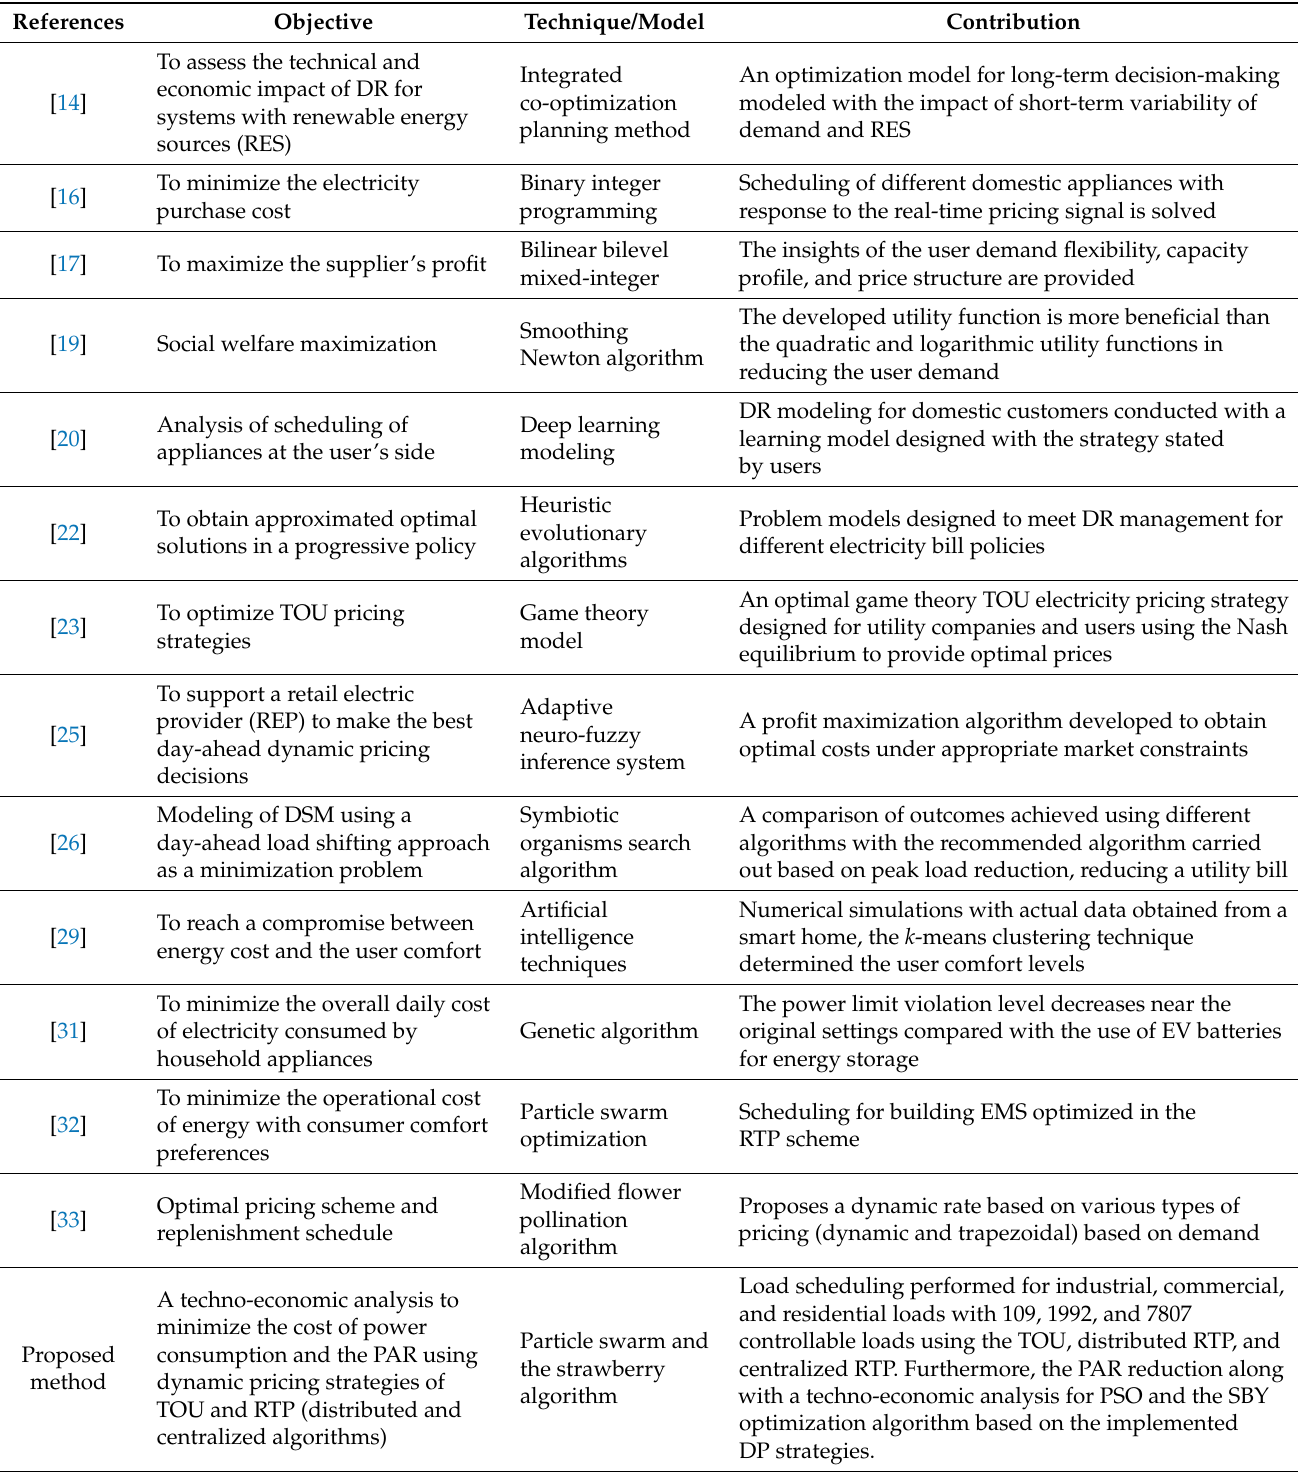
Table 1. Comparison of the references based on their objective and